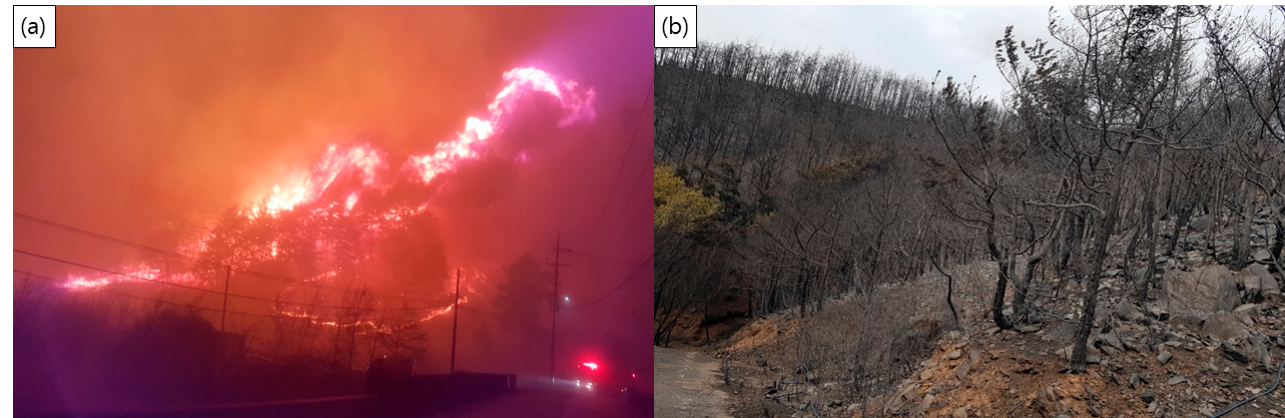
Figure 2. ( a ) Front line of the spreading forest fire in Okgye forest on 4 April 2019 (photograph by Gangwon Province), and ( b ) severely burned Okgye forest three days after the fire (photograph by East Coastal Forest Fire Center of Gangwon Province).